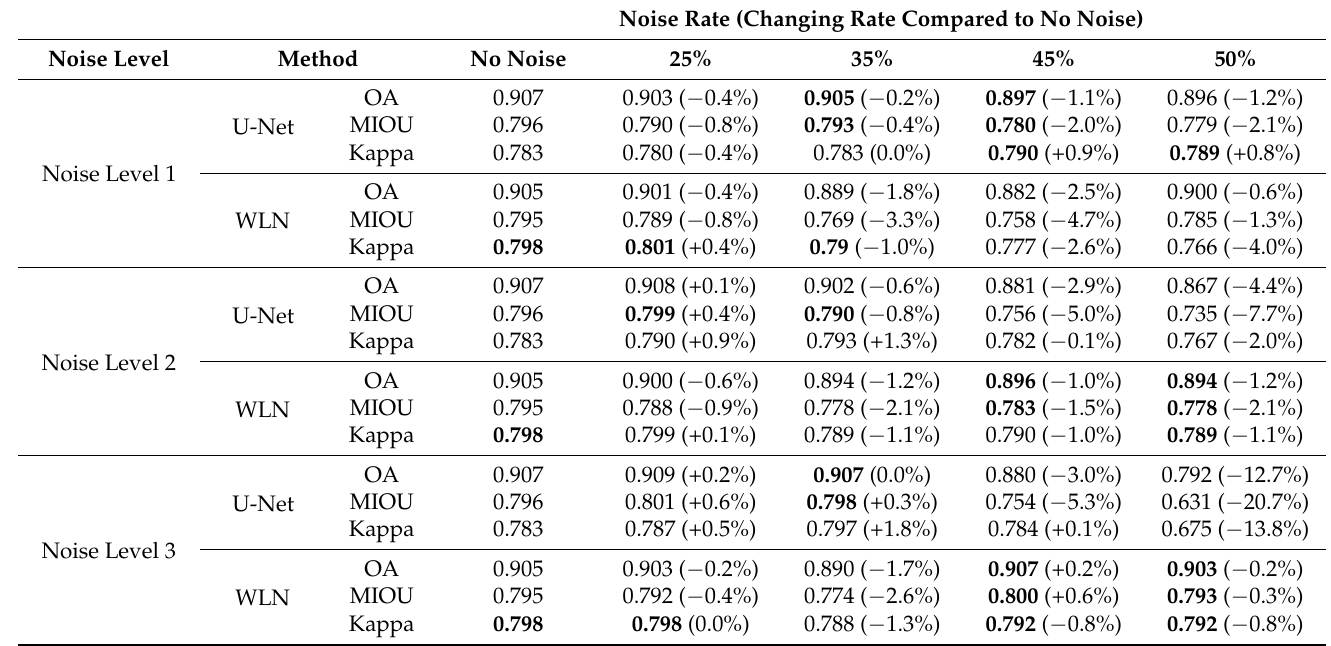
Table 1. Comparison of the performance of WLN and U-Net with dilated samples. MIOU: Mean Intersection over Union. Noise Rate (Changing Rate Compared to No Noise) Noise